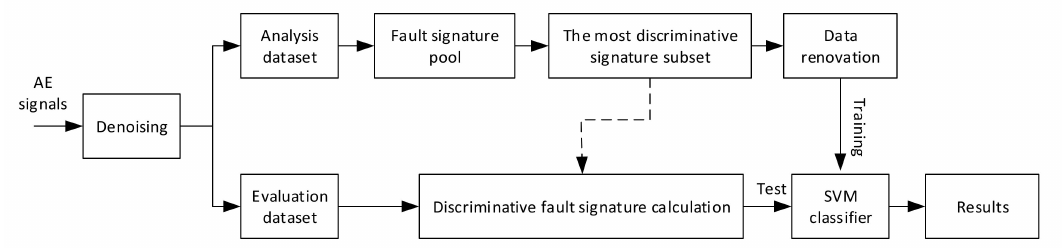
Figure 1. The overall flow diagram of the leak detection